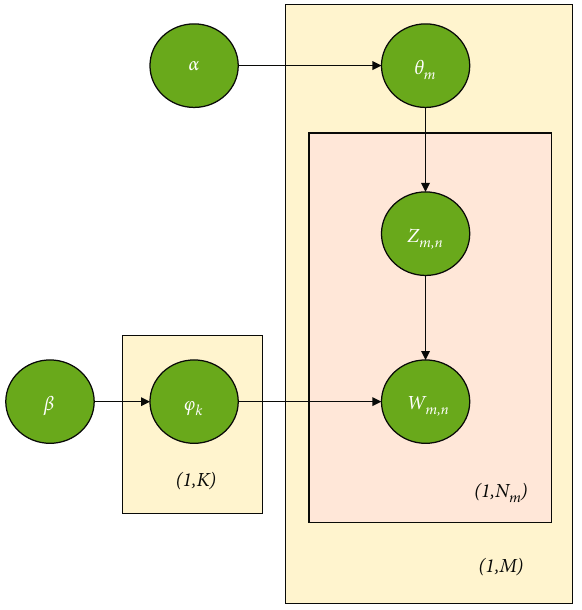
Figure 2: LDA Bayesian graph